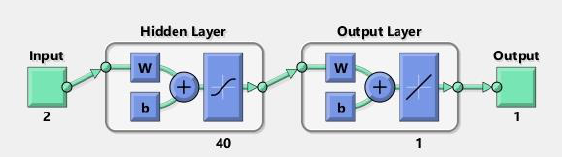
Figure 5. The chosen network architecture for the vault in Figure 1.